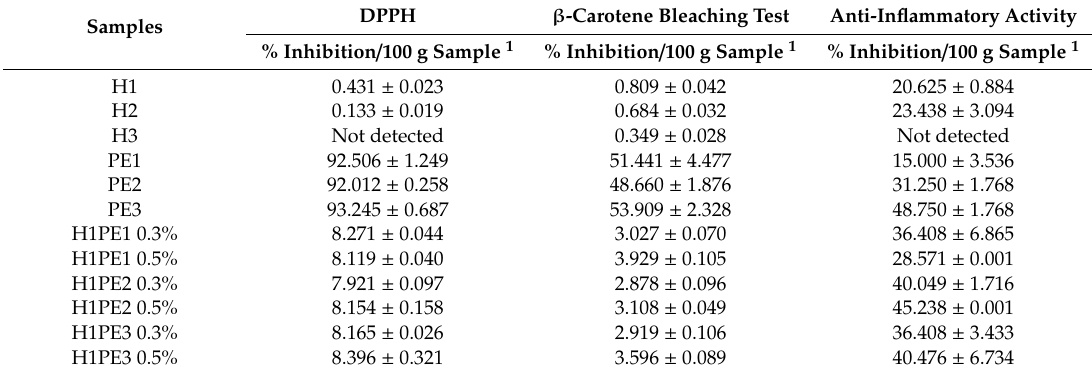
Table 2. Antioxidant and anti-inflammatory activities of the